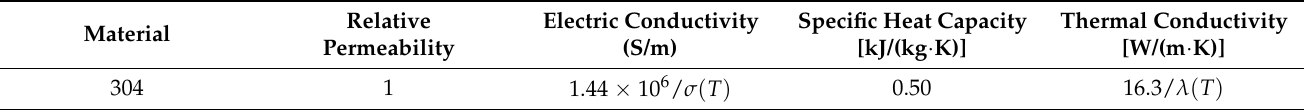
Table 1. Physical parameters of 304 stainless